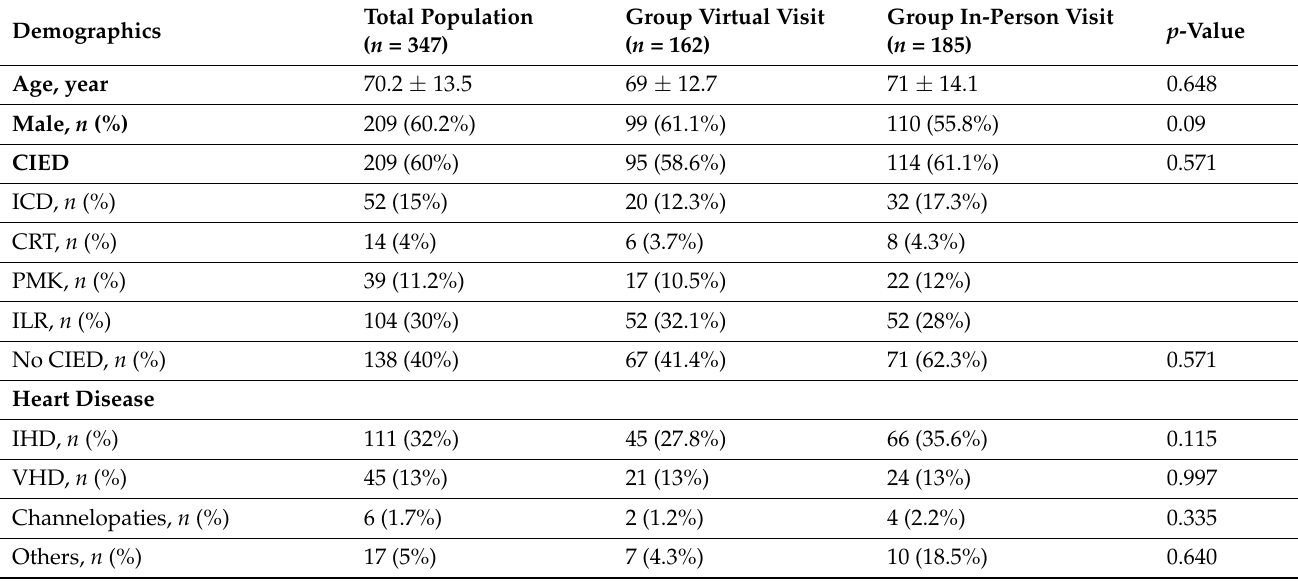
Table 1. Baseline population